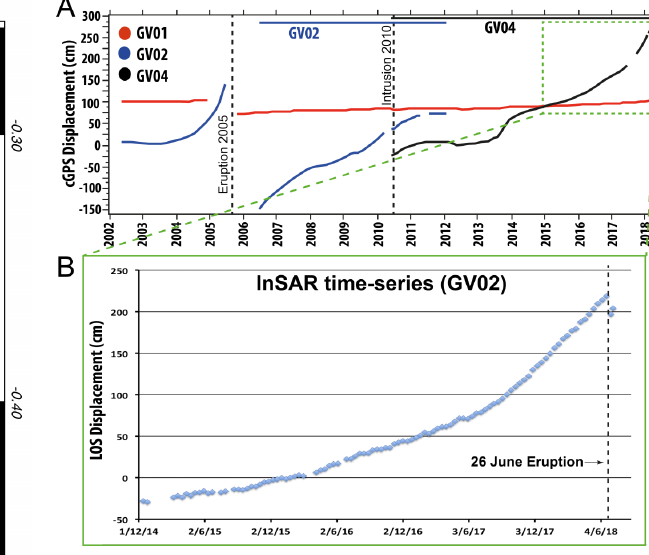
Figure 3: [A] Time-series of the vertical component for three cGPS stations on the rim (GV01) and within the caldera (GV02, GV04) at Sierra Negra provided by Penn State (see Figure 5 for locations). The cu- mulative uplift exceeds 4.5 meters. The cGPS sta- tions provide high-temporal sampling of the deforma- tion signal. [B] Green box shows the time-series in- version assessed by InSAR since 2014 on GV02’s lo- cation using Sentinel-1 (128-path) taken from RSMAS (https://insarmaps.miami.edu/). Note that cGPS and InSAR trends looks similar in the same period of time. Dashed lines show important events in the